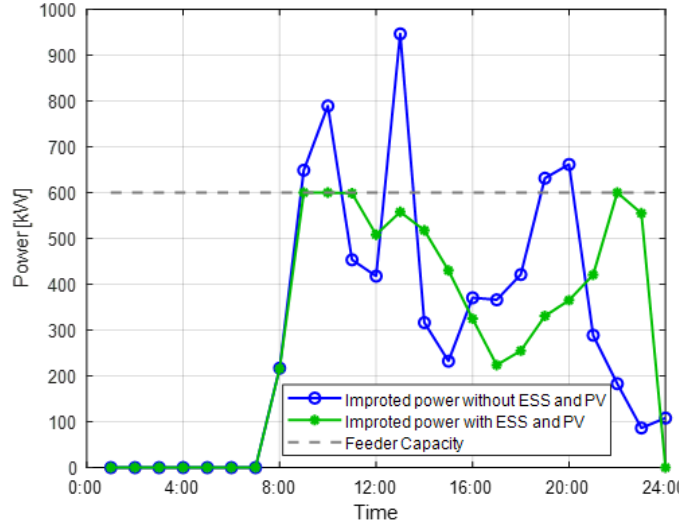
Figure 12. ESS operation at XFC8 on a summer ’s day.